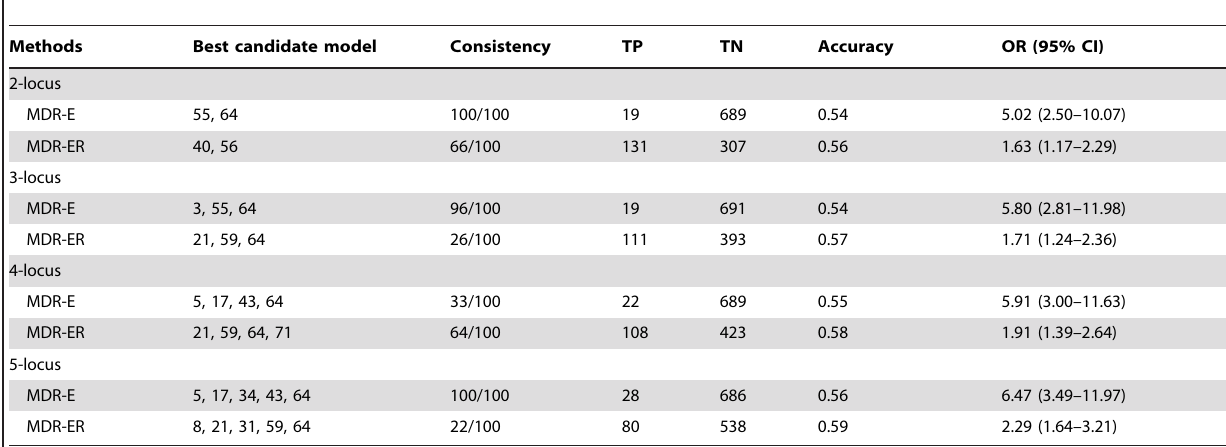
Table 2. Estimated effect (odds ratio and 95% CI) from individual SNPs of 23 steroid hormone metabolisms and signalling-related genes on the occurrence of breast cancer in